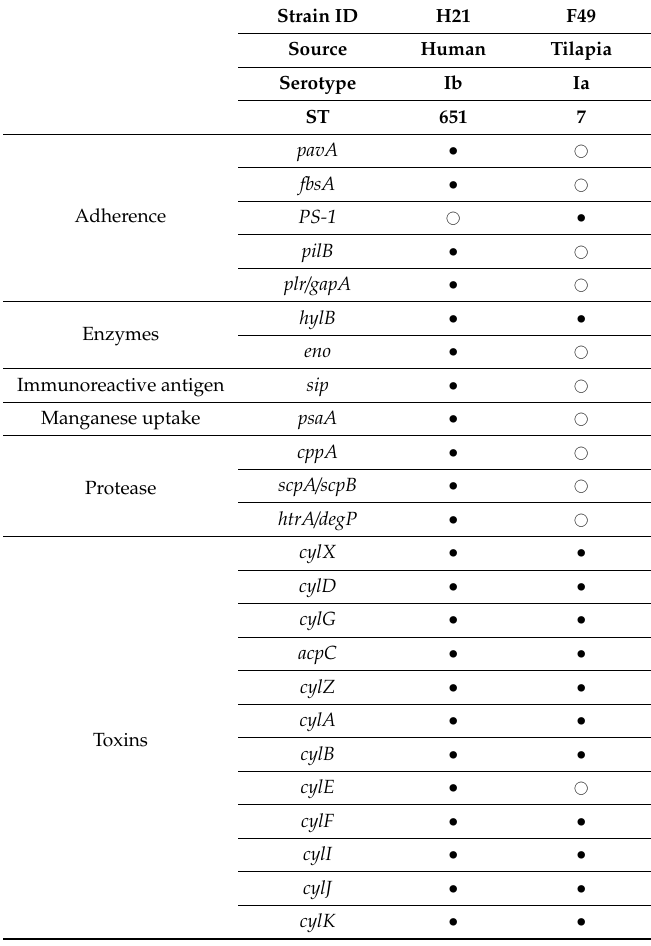
Table 5. Virulence genes comparison of H21 and